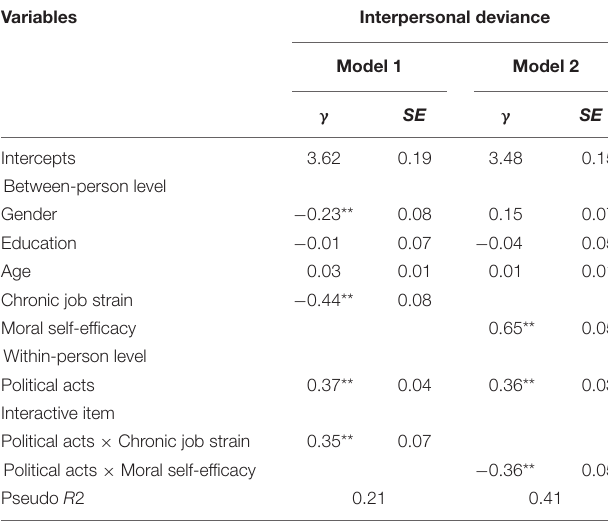
TABLE 2 | Results of hierarchical linear